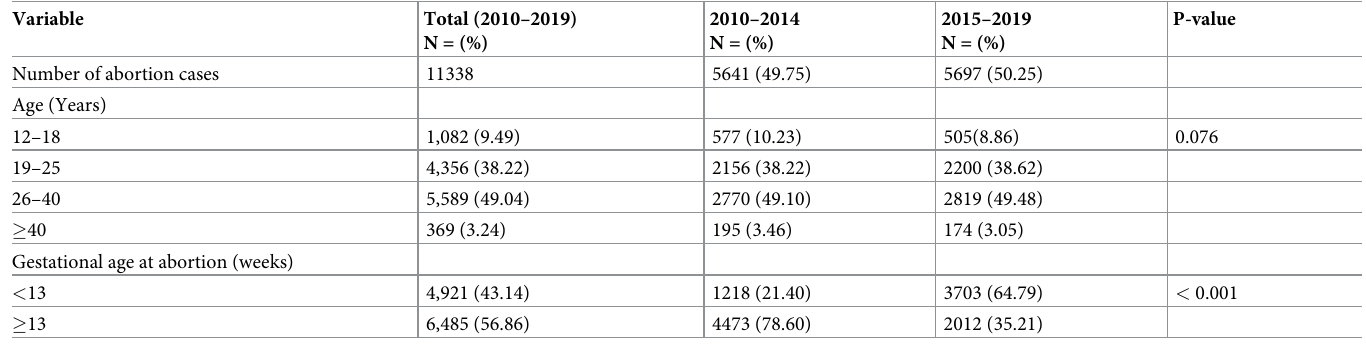
Table 1. Comparison of number of abortions, age and gestation at termination across two time